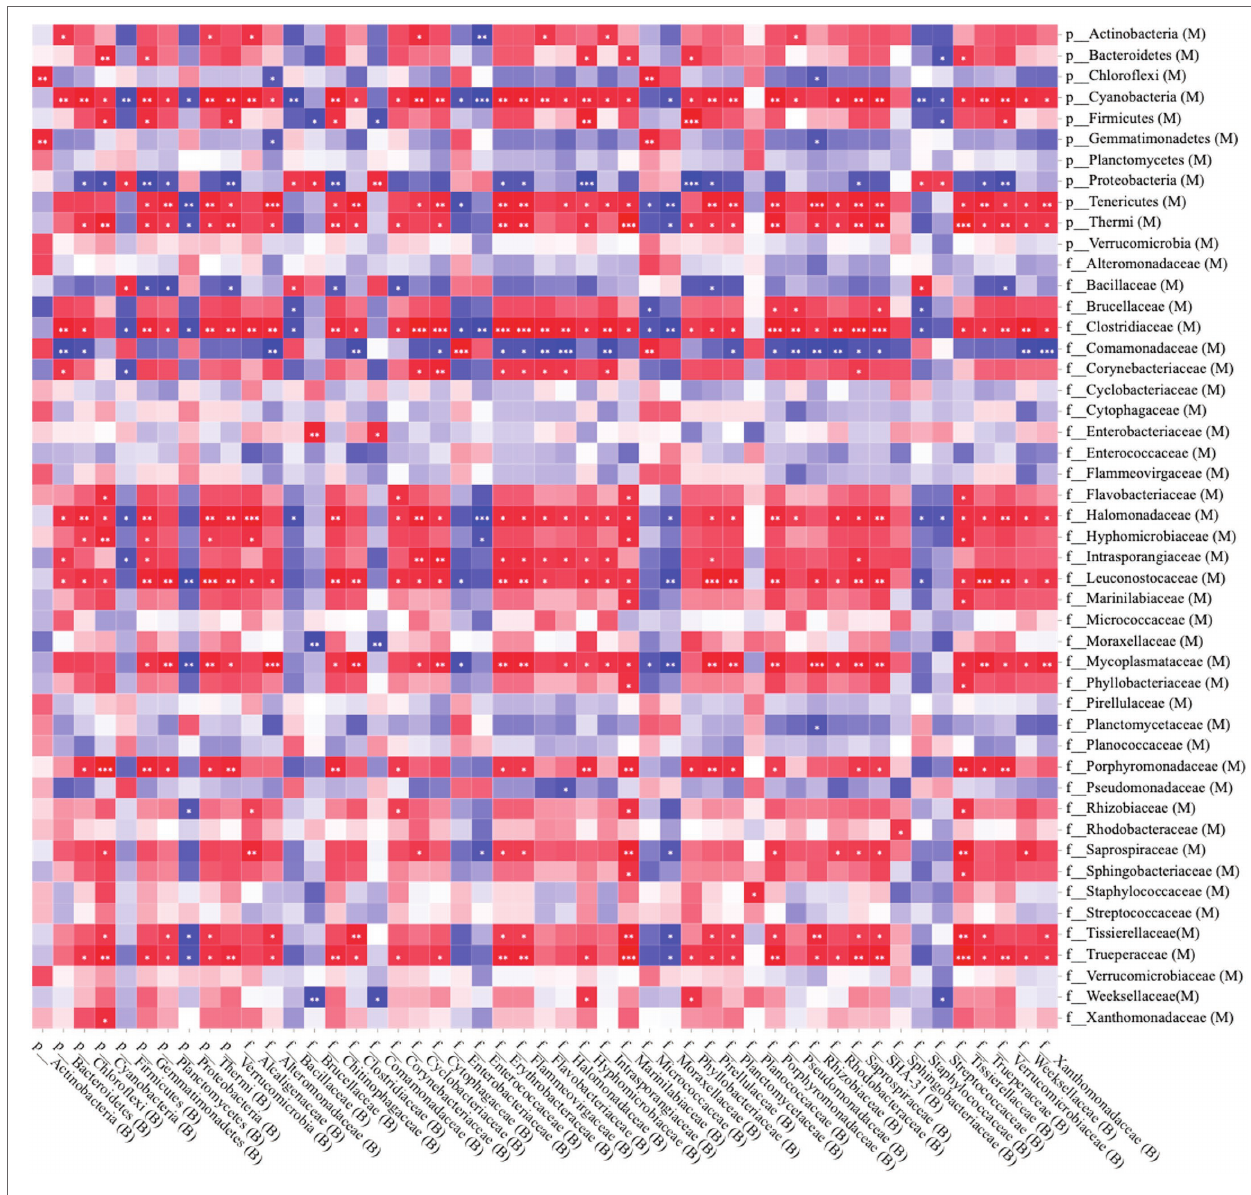
FIGURE 1 | Spearman correlation analysis between bedding bacteria and milk bacteria at the phylum and family levels; red squares: positive correlation; blue squares: negative correlation; * p < 0.05; ** p < 0.01; and *** p ≤